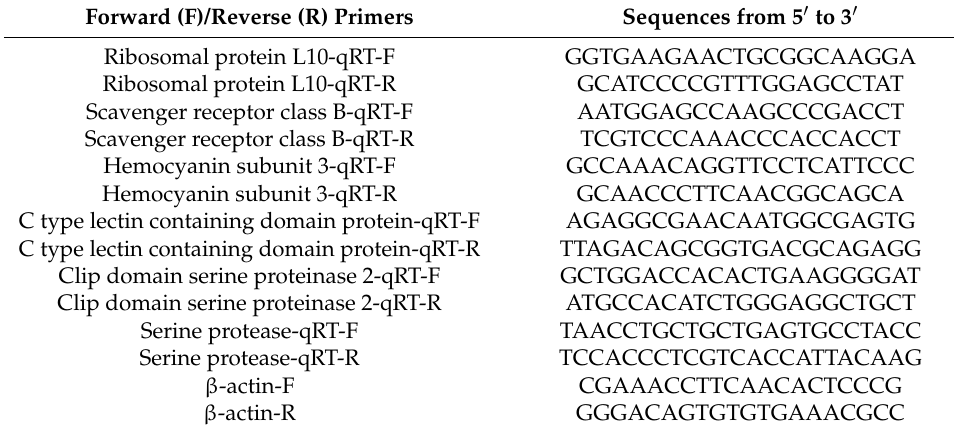
Table 1. qRT-PCR primers used in this study. Forward (F)/Reverse (R) Primers Sequences from 5 (cid:48) to 3 (cid:48) Ribosomal protein L10-qRT-F Ribosomal protein L10-qRT-R